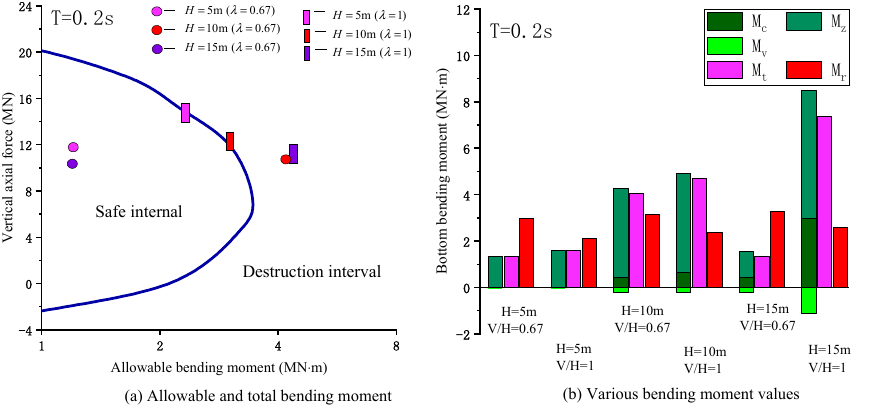
Figure 8. Various bending moments and allowable bending moments at the pier bottom: ( a ) Changes of various bending moments at the bottom of the pier at three different heights; ( b ) Longitudinal relative displacement of pier beam under different pier height.